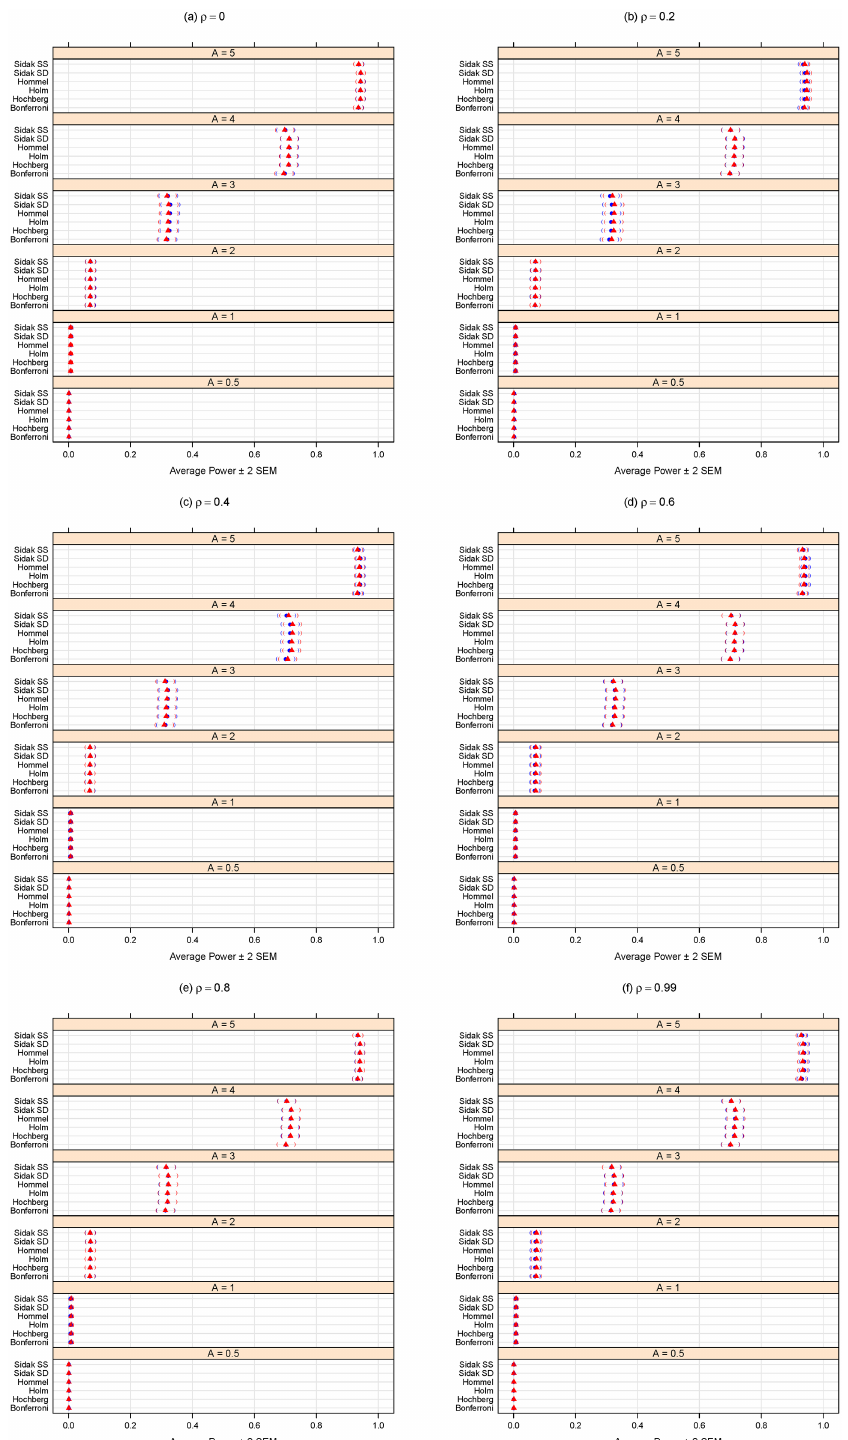
Fig 2. Average power for different methods purporting to control the FWER at α = 0.05. A can be thought of as the magnitude of differential abundancefor truly differentiallyabundantfeatures, and ρ is the true correlationwithin blocks of dependent tests. The blue solid circles represent the case of 18 dependent tests (out of 100 total), whereasthe red solid trianglesare for the case of 36 dependent tests. Parentheses indicate ± 2